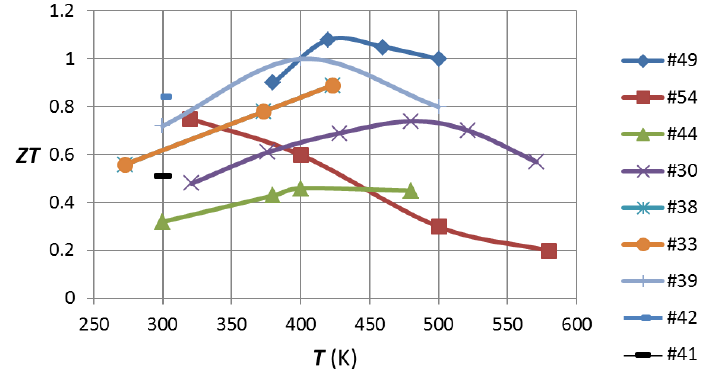
Figure 4. Plot of ZT against T for n-type bismuth telluride alloys. The sources of the values are the reference numbers as